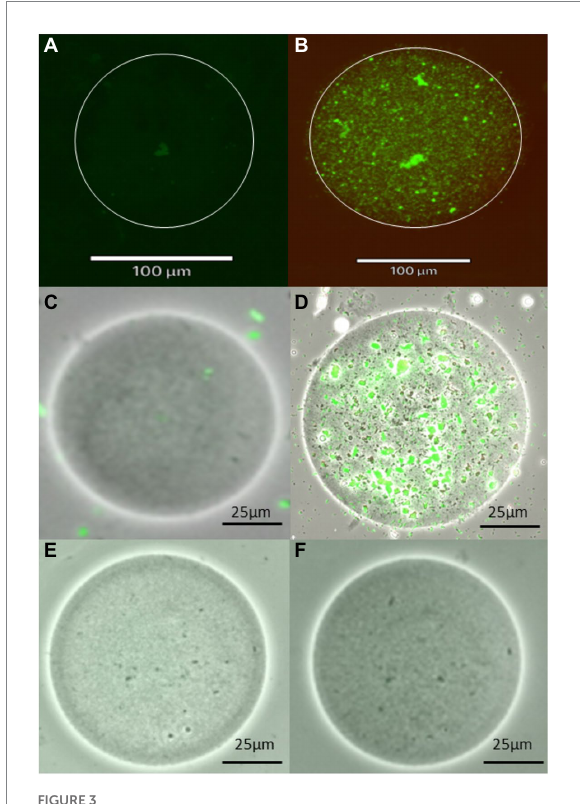
FIGURE 3 Images of agarose microbeads, including a microbead containing a single marine sediment bacterial cell before incubation (A,C) and the growth of numerous cells within the agarose microbead following incubation (B,D) using fluorescent and brightfield imaging, respectively as well as images of blank beads without any bacteria (E,F) . Images were obtained using Live/Dead bacterial stain and Revolve4 microscope with a 20× objective